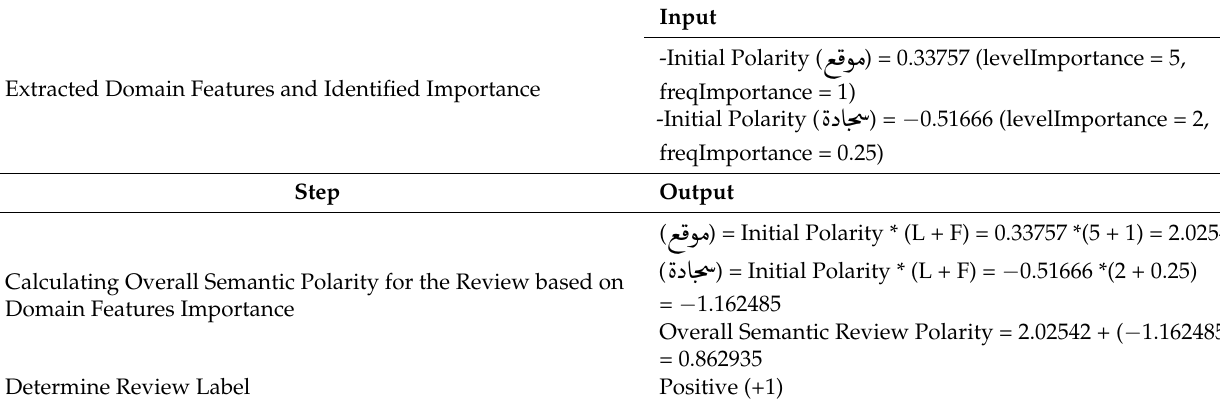
Table 9. Example of calculating overall semantic review